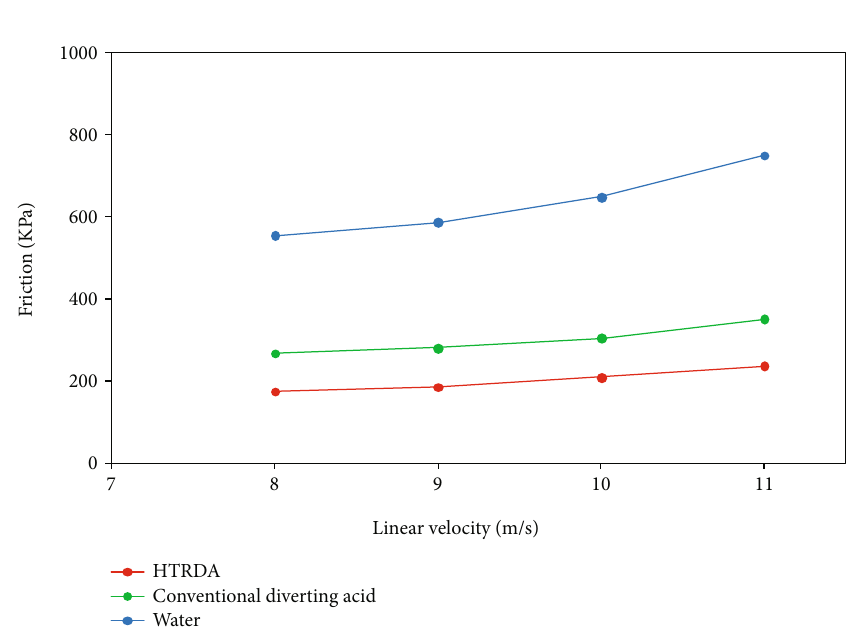
Figure 1: Relationship between peak viscosity and temperature.